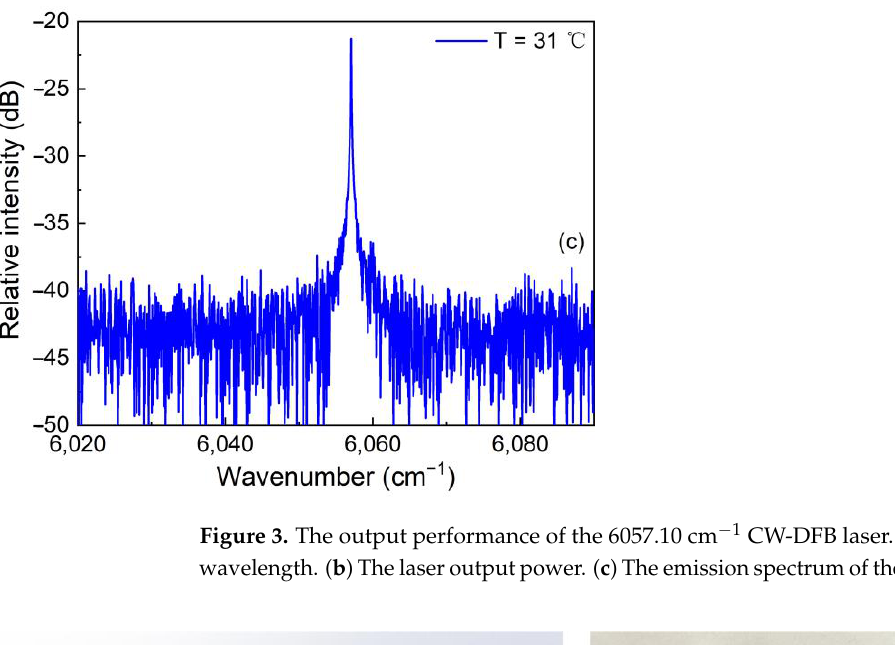
Figure 4. Schematic diagram of 3D-printed ADU: ( a ) design pattern; ( b ) assembled ADU.